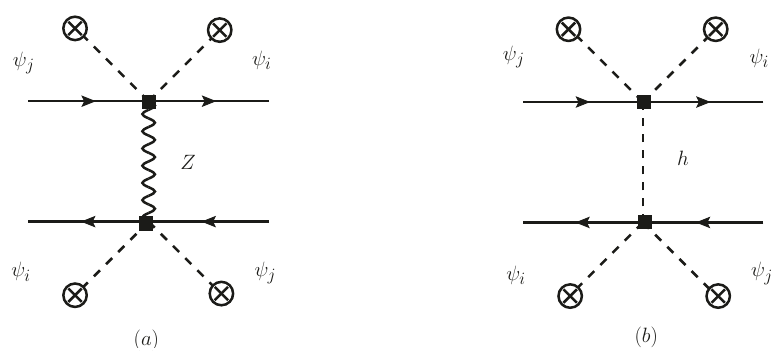
( v 4 =M 4 ) induced O